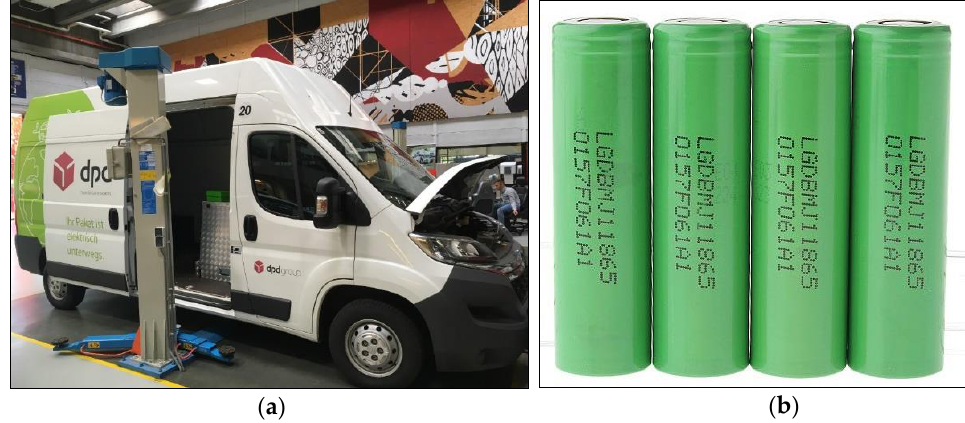
Figure 1. ( a ) The eVan20, the project demonstrator, and ( b ) the LG MJ1 cells of the battery pack. The new battery pack for this demonstrator would have a total capacity of 48 kWh, a nominal voltage of 610 V, a maximum charge current of 34 A, a minimum voltage of 420 V and a maximum voltage of 705 V. The battery features 3840 LG MJ1 cells arranged in a 192 serial × 20 parallel configuration. Each cell has a cylindrical shape and standard di- mensions (diameter 18.65 mm; height 65.30 mm), see Figure 1b. The operating conditions and requirements considered in the project for the design of the BTM system were: •